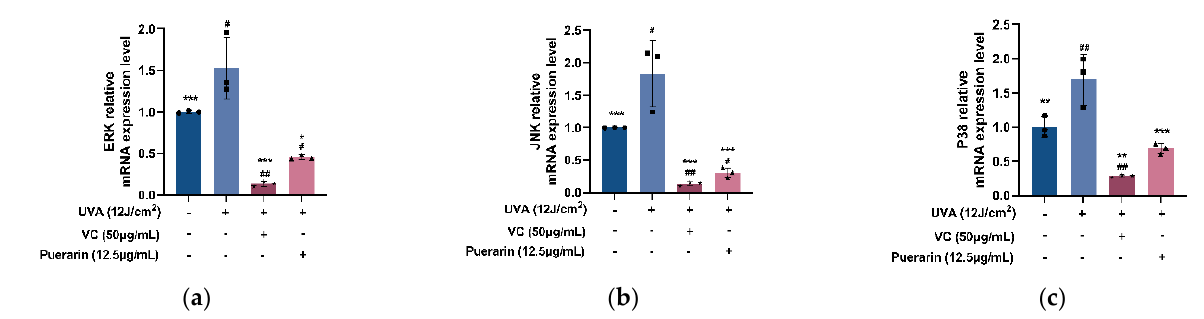
Figure 5. Effects of puerarin on UVA-induced mitogen-activated protein kinase (MAPK) signaling in HSF: ( a – c ) RT-PCR analysis of human extracellular signal-regulated kinase (ERK), human c-Jun amino-terminal kinase (JNK), and P38 mRNA expression levels after treatment and UVA irradiation of samples. # p < 0.05, ## p < 0.01 as compared to the control group; * p < 0.05, ** p < 0.01, *** p < 0.001 as compared to the damage model group; Values do not have a common mark ( # , *) when p > 0.05, ( n = 3).